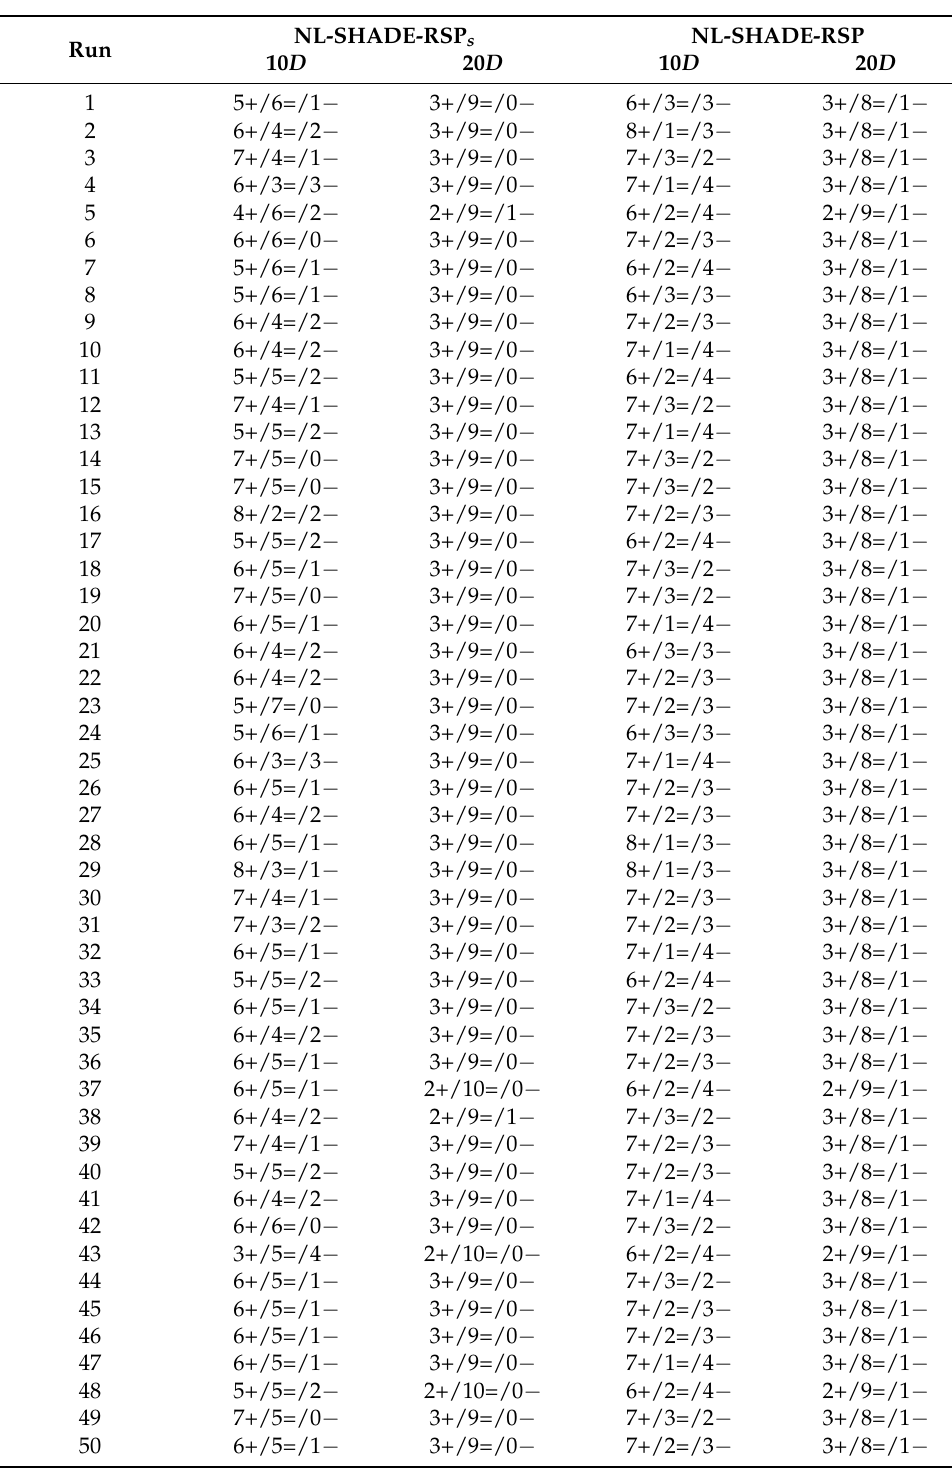
Table 2. Comparison of HA-NEAT-DBM heuristics on CEC 2022 benchmark functions, Mann–Whitney